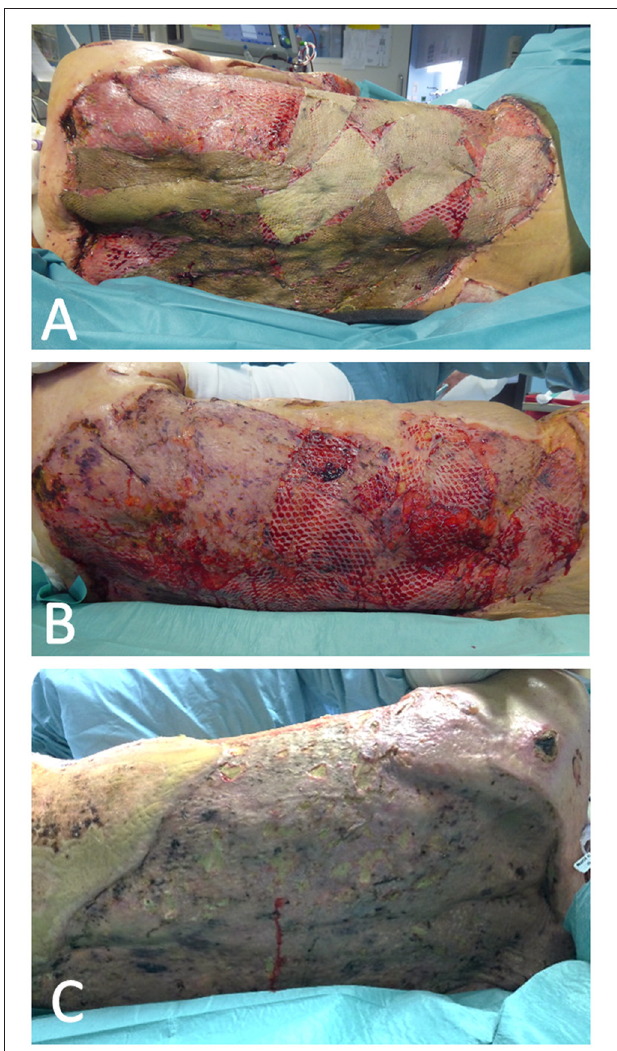
FIGURE 5 | Satisfying result of debridement and autologous skin grafting after a decrease in bilirubin concentration following the use of CytoSorb. An allogenous skin graft was used as a protective layer (A) and was removed about 10 days after surgery, leaving only an autologous graft (B) , which showed good integration and wound closure with only small defects 4 weeks after the surgery (C)